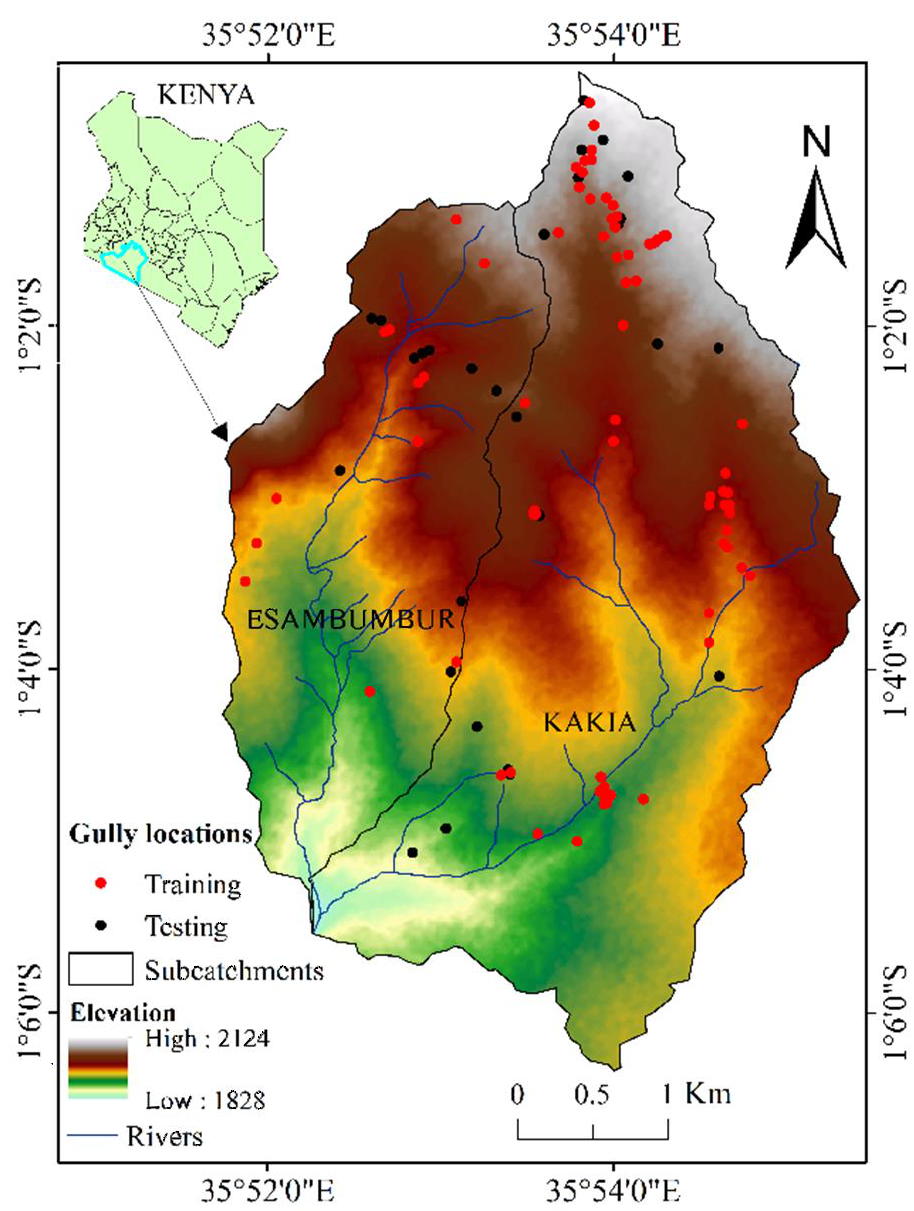
Figure 1. Map of Kakia-Esamburmbur catchment showing the training and testing datasets for mod- eling.